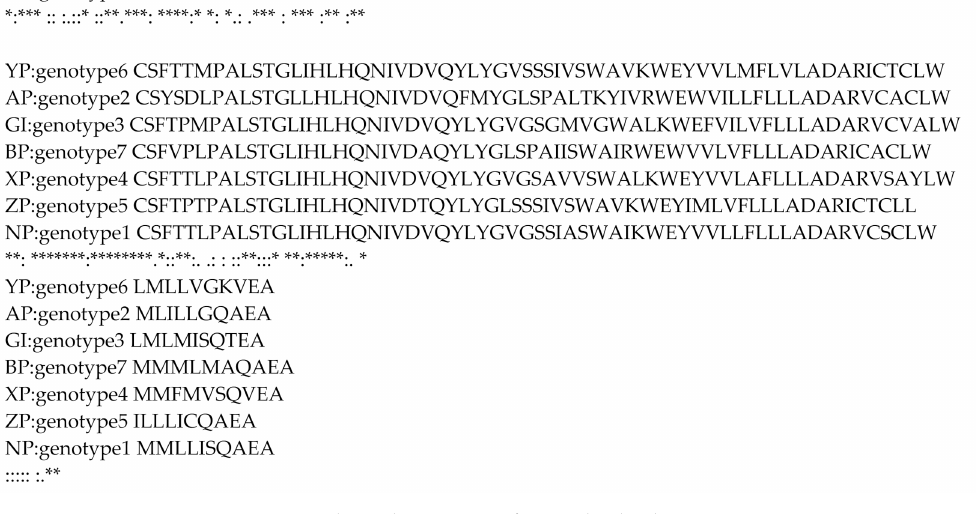
Figure 1. Aligned sequence after multiple